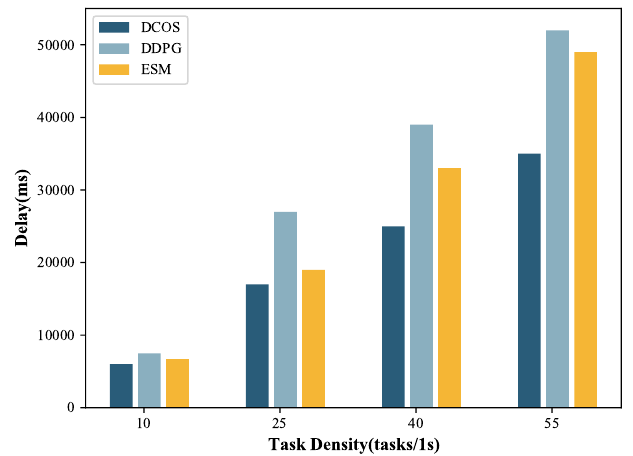
Figure 4. Delay comparison on different task